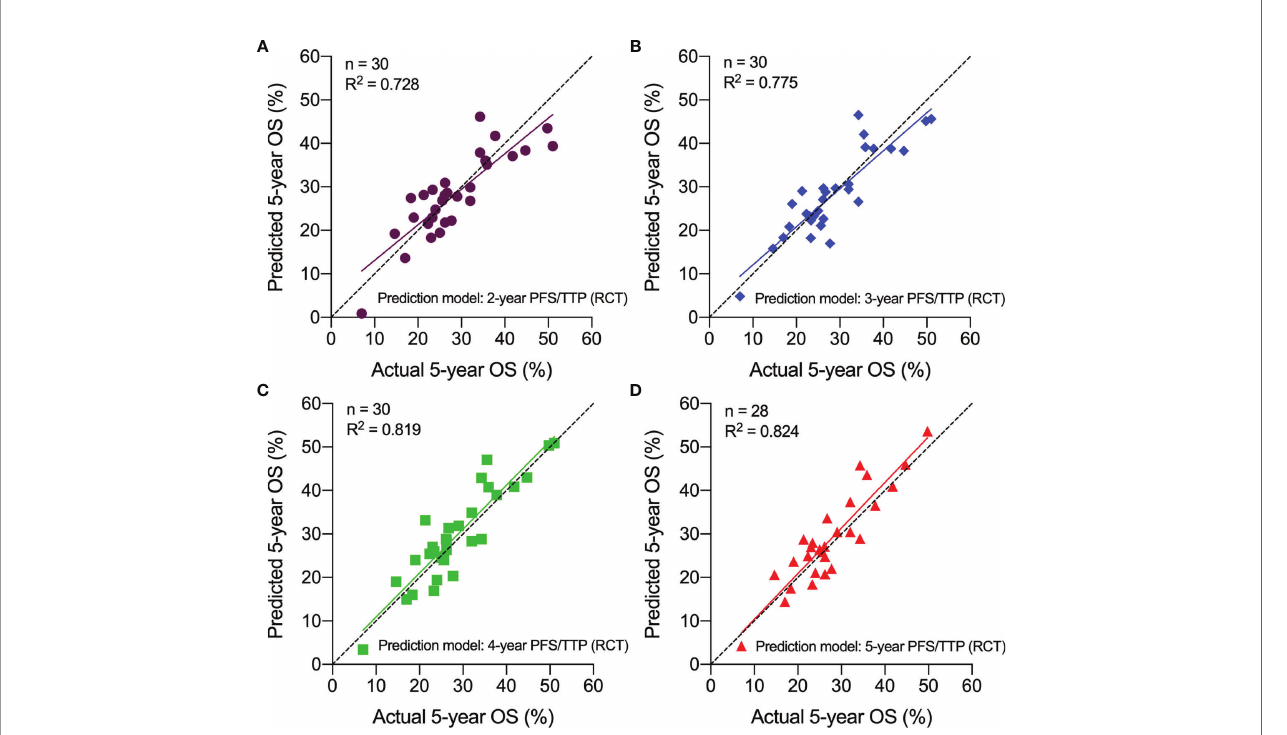
FIGURE 5 | External validation of the correlation between PFS/TTP and OS in Phase II and retrospective studies. The predicted 5-year OS based on actual 2-year PFS/TTP (A) , 3-year PFS/TTP (B) , 4-year PFS/TTP (C) , and 5-year PFS/TTP (D) is plotted against the actual 5-year OS. OS, overall survival; PFS/TTP, progression- free survival/time to progression; RCT, randomized controlled